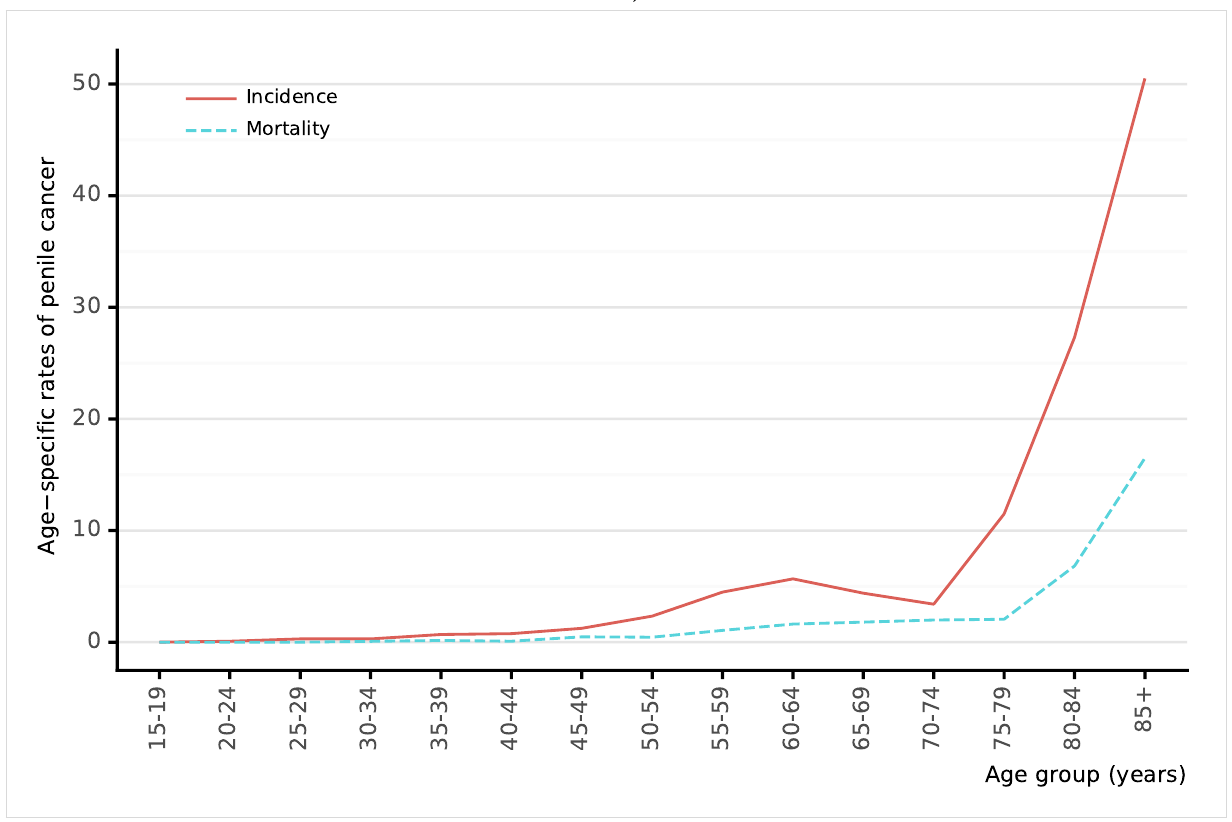
Figure 35: Comparison of age-specific penile cancer incidence and mortality rates in Peru (estimates